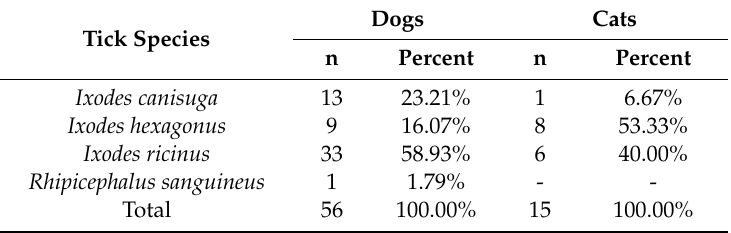
Table 1. Tick species detected on dogs and cats.